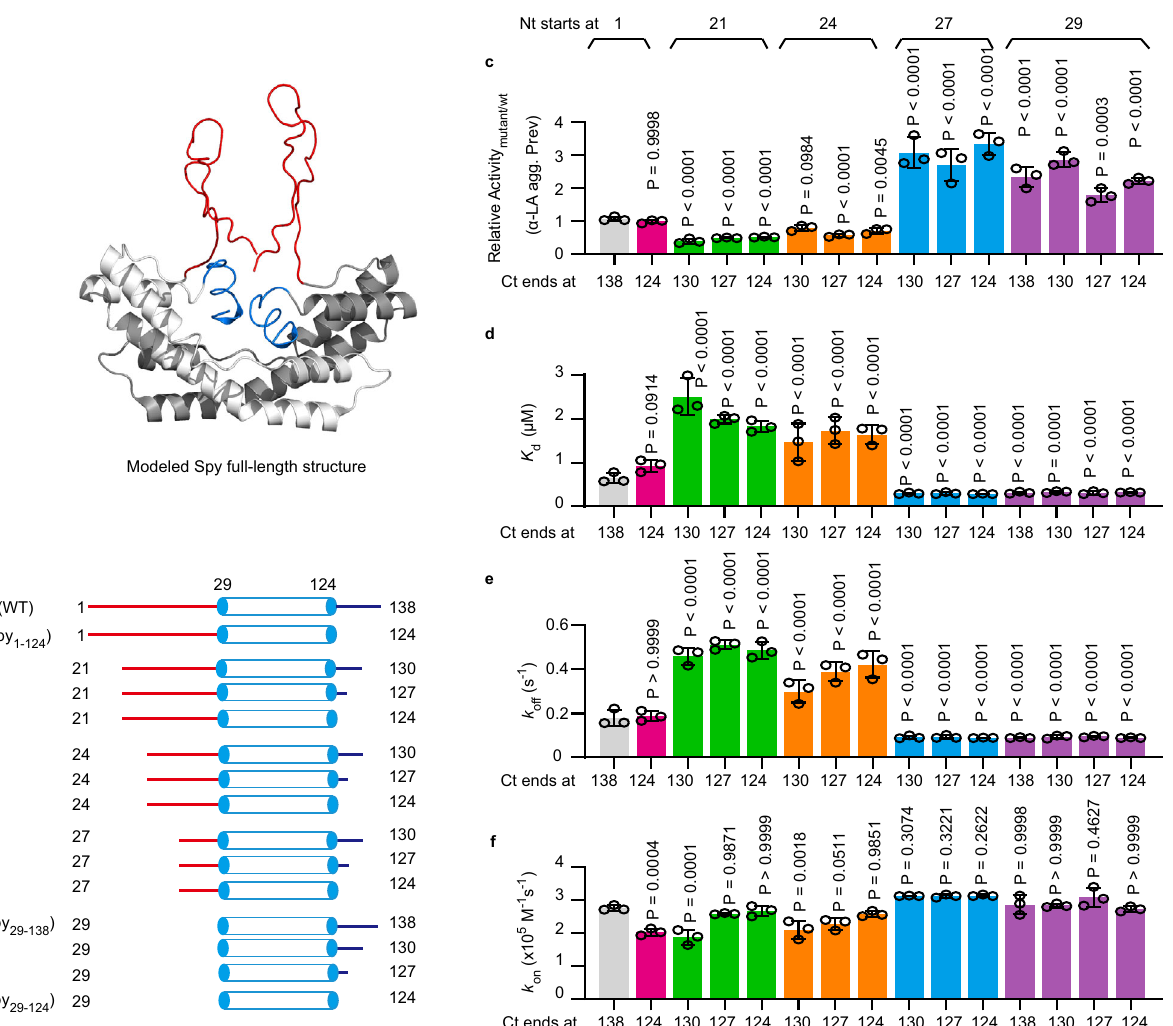
Fig. 1 The disordered N terminus of Spy is involved in client protein release. a Structure model of full-length Spy with the N- and C-termini colored in red and blue, respectively. The disordered termini were modeled using the CABS-dock software and docked to the crystal structure of Spy (PDB: 3O39), in which only residues 29 – 124 are visible 15 . For clarity, only one possible conformation of the termini is shown. b Schematic illustration of termini-truncated Spy variants used for the chaperone activity assay and kinetics assessment, where the numbers listed as suf fi xes describe the amino acids remaining in the variants, using this nomenclature wild type Spy is Spy 1-138 . The structured regions of Spy 29-124 are represented by blue cylinders, and the N- and C-termini are shown as red and blue lines, respectively. c Chaperone activities of termini-truncated Spy variants in inhibiting the aggregation of DTT-reduced α -LA relative to the activity of Spy wild type. Abbreviation α -LA agg. Prev means α -LA aggregation Prevention. Comparison of the dissociation constants K d ( d ), dissociation rate constants k off ( e ), and association rate constants k on ( f ) between termini-truncated Spy variants using the model client protein Im7 AAW as the chaperone substrate. For c – f , individual data points (circles) and mean ± SD ( n = 3 independent experiments) are shown. Statistical analysis was performed with Graphpad Prism 9.1.0 using one-way ANOVA with Tukey ’ s multiple comparisons test. Source data are provided as a Source Data fi